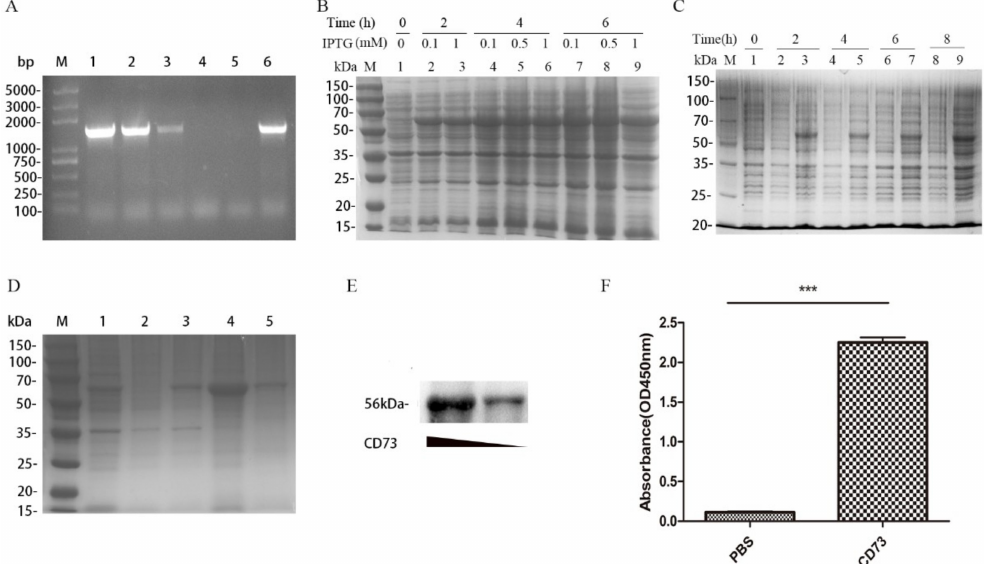
Figure 1. The expression of the CD73 protein: ( A ) the PCR identification of positive clones, where Lane M is the DNA markers and lines 1–6 are the selected clones from the LB plate medium containing kanamycin; ( B ) the SDS-PAGE analysis of the protein expression at different concentrations of IPTG; ( C ) the SDS-PAGE analysis of the expression of the CD73 protein; ( D ) the SDS-PAGE analysis of the refolding of the CD73 protein, where M is the molecular weight markers, line 1 is the BL21 lysate resuspended by PBS, line 2 is the lysate supernatant after ultrasonication, line 3 is the lysate sediments after ultrasonication, line 4 is the inclusion bodies, and line 5 is the soluble CD73 protein after refolding; ( E ) the Western blot of different concentrations of the soluble CD73 antigen; and ( F ) the Enzyme-Linked Immunosorbent Assay (ELISA) analysis of the soluble CD73 protein. Data were shown as means ± SD and analyzed by two tailed t -test; *** p < 0.001. Data were representative of at least three independent experiments.2.2. Characterization of Anti-CD73